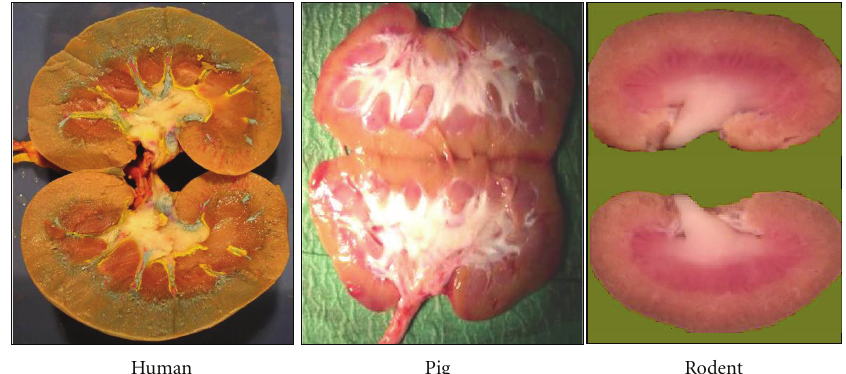
Figure 2: Renal anatomical comparisons between human, pig and rodent [26]. Multilobular and multipapillary kidneys observed in human and pig contrast with unilobular and unipapillary kidney in rodent